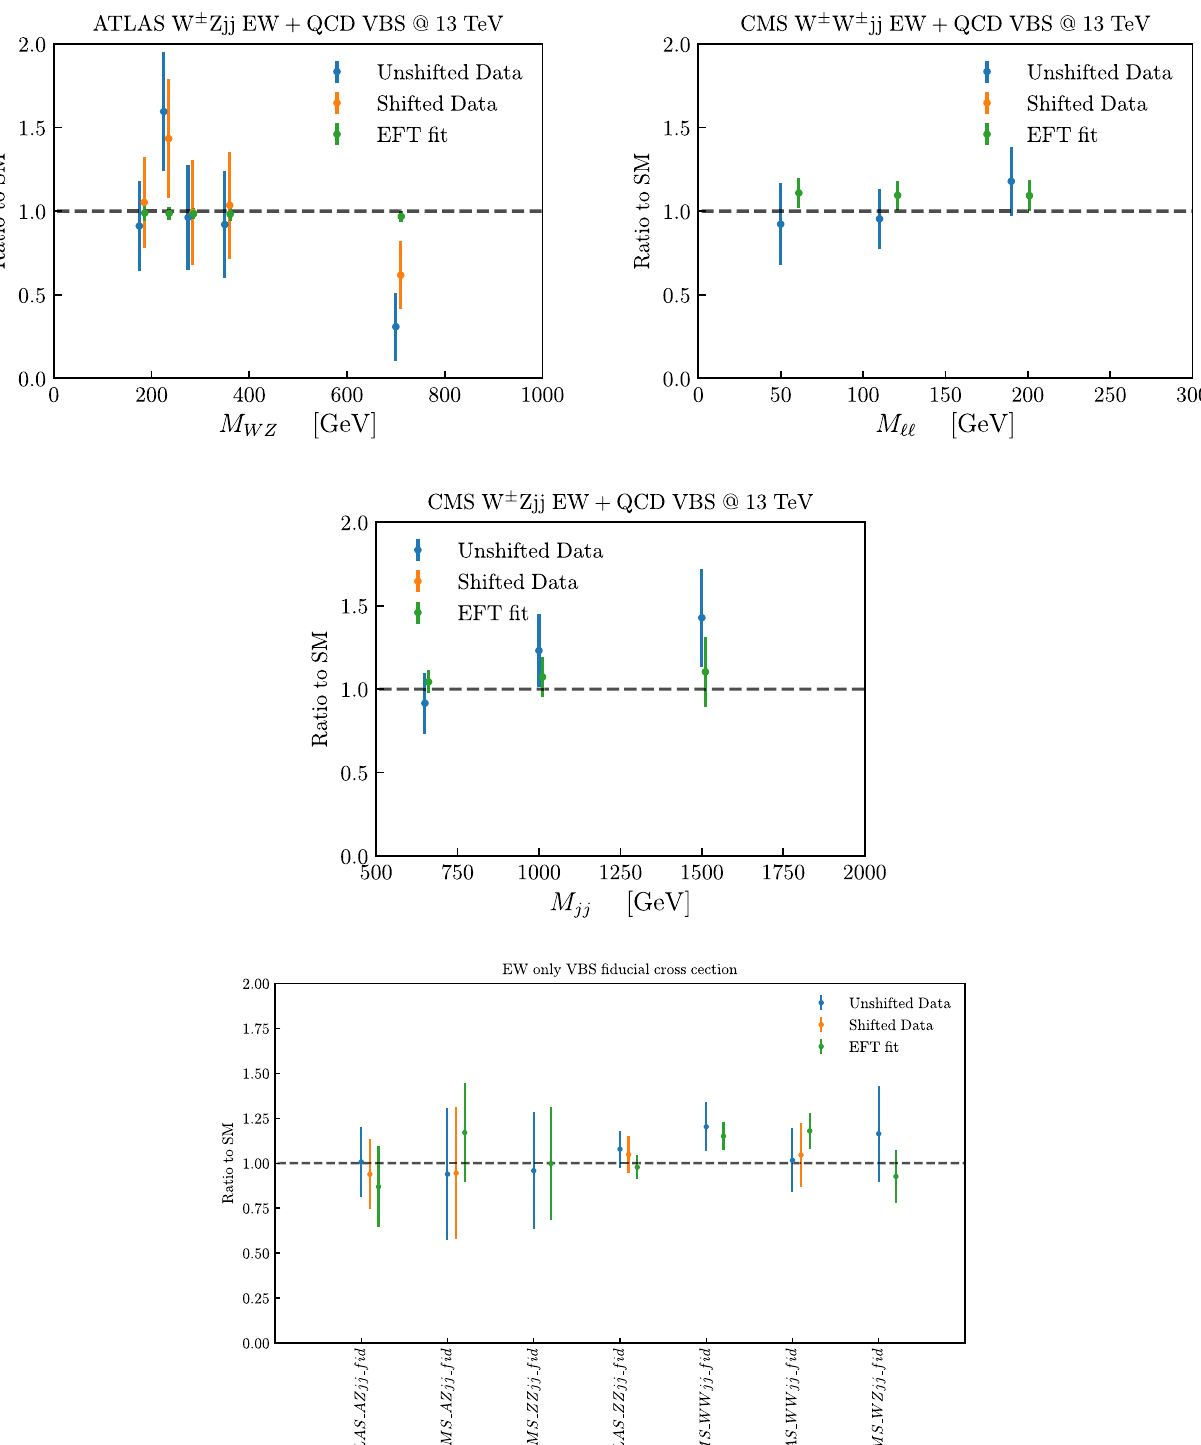
Fig. 18 Comparison for the VBS measurements, both for the unfolded differential distributions (top panel), and for the EW-only fiducial cross- sections (bottom